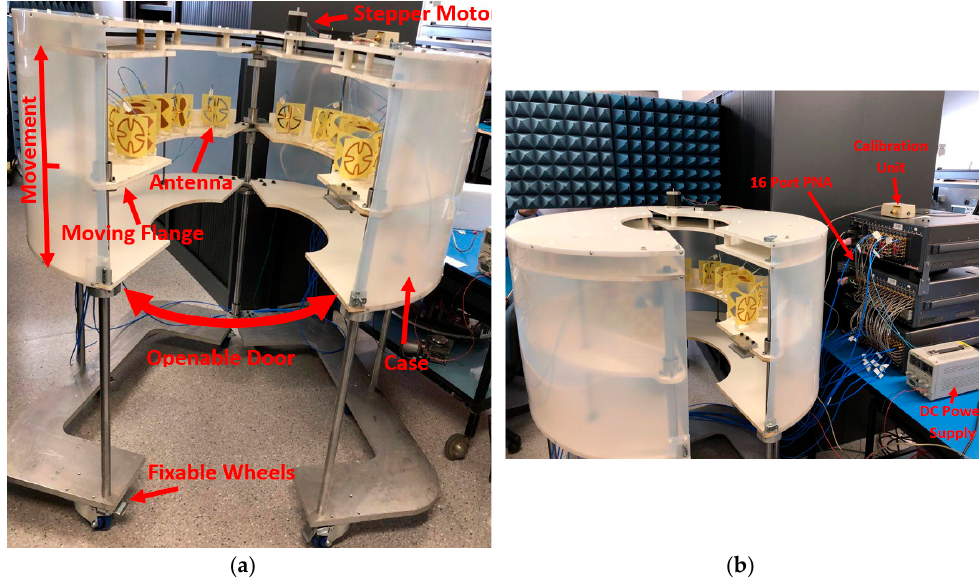
Figure 1. ( a ) Proposed 3D torso scanning system and ( b ) its testing environment.